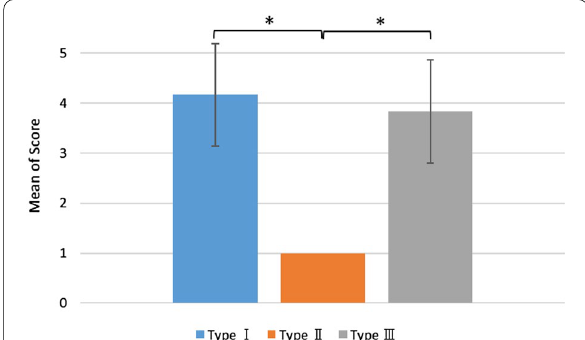
Fig. 10 Means of the score for each type during the